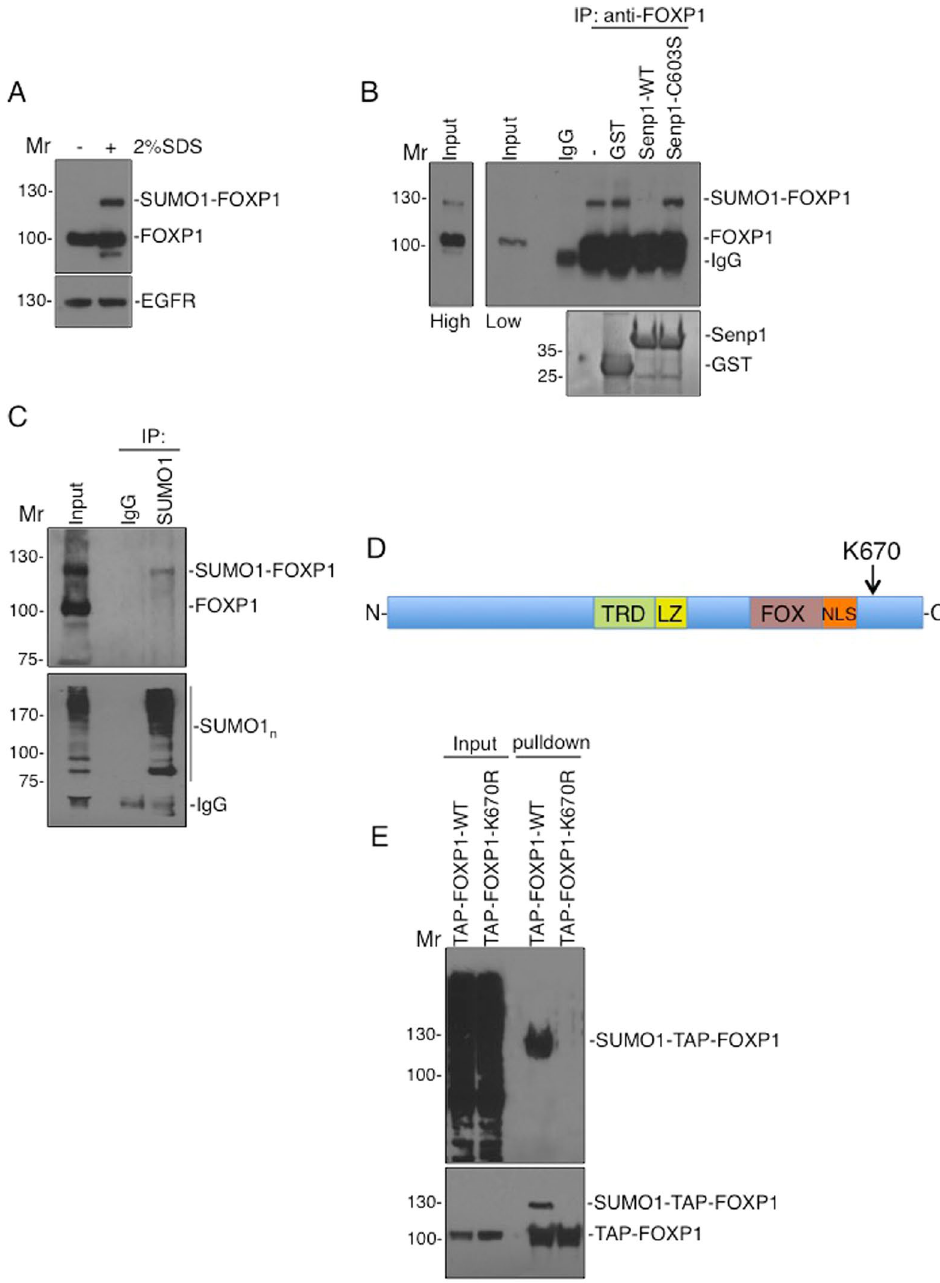
Figure 1. FOXP1 is SUMOylated at K670. ( A ) DIV7 cortical neuronal cultures were lysed in buffer with or without 2% SDS and immunoblotted with FOXP1 antibody. Under denaturing conditions a prominent additional higher molecular weight FOXP1 band was observed. ( B ) Following lysis in 2% SDS containing buffer, the SDS was diluted to 0.1% and FOXP1 immunoprecipitated and incubated with GST, GST-WT-Senp1 catalytic domain or GST-Senp1-C603S catalytic domain. Immunoblots with FOXP1 antibody (top panel) shows the higher Mr band is removed by Senp1 treatment consistent with it being SUMOylated FOXP1. A high exposure (top left panel) of the input shows the presence of the modified-FOXP1. Lower panel shows equal levels of purified GST-SENP proteins by coomassie staining. ( C ) Immunoprecipitation was performed as in B, using a SUMO-1 antibody, followed by immunoblotting with either FOXP1 (upper panel) or SUMO1 (lower panel) antibodies. SUMO1-modified FOXP1 corresponds to the high Mr band in the input. Note the enrichment of SUMO1-ylated proteins (seen as a smear) in the IP lane but not the control IgG. ( D ) Schematic of FOXP1 showing the putative SUMOylated lysine. TRD, transcriptional repression domain; LZ, leucine zipper; FOX, FOX homolgy domain; NLS, nuclear localisation signal. ( E ) FOXP1 is SUMOylated at lysine 670. HEK293T cells were transfected with either TAP-FOXP1-WT or the mutant TAP-FOXP1-K670R, lysed in buffer containing NEM, to inhibit SUMO proteases, and precipitated using strepavidin beads before subsequent immunoblotting with anti-SUMO1 (top panel) or anti-SBP (lower panel)